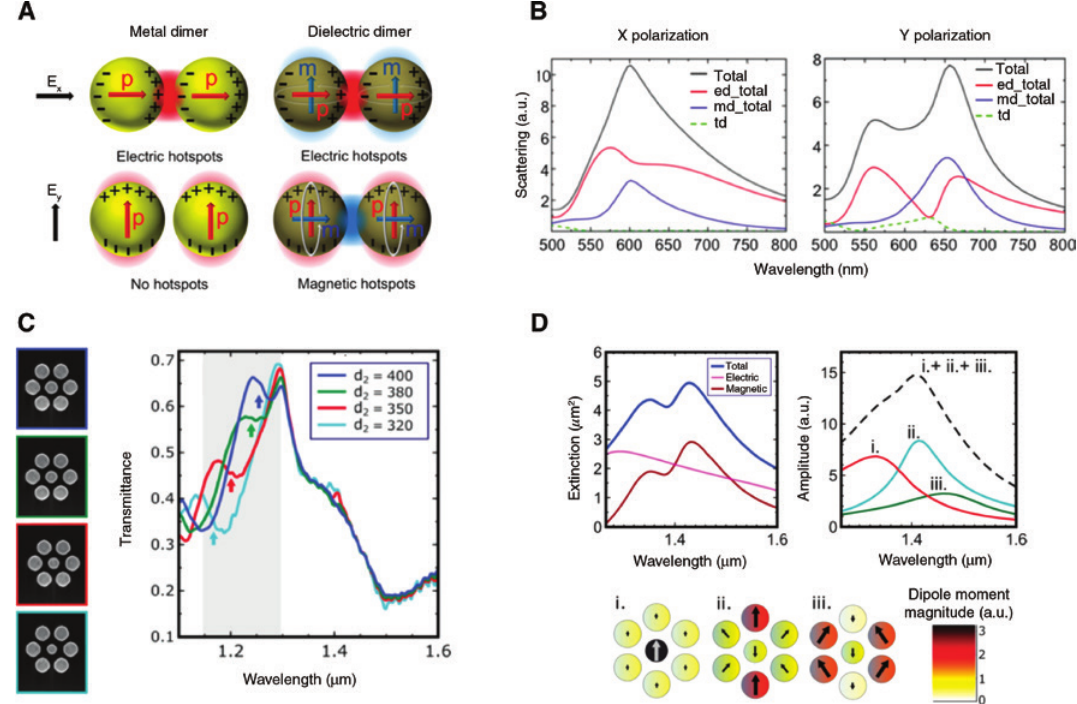
Figure 8: Recovering Fano-like magnetic modes through dielectric oligomers. (A) Comparison of metallic (plasmonic) and dielectric nanodimers: dielectric nanoparticles support both electric and magnetic dipoles that couple with both orthogonal polarizations of the incident light field. (B) Numerical results for a silicon dimer. X- (left) and Y-polarized (right) light scattering spectra with mode decomposition. Adapted with permission from Bakker RM, Permyakov D, Yu YF, et al. Magnetic and electric hotspots with silicon nanodimers. Nano Lett 2015;15:2137–42 (Ref. [57]). Copyright 2015 American Chemical Society. (C) Left, scanning electron micrographs of the fabricated heptamer oligomers featuring different diameters of the central nanoparticle. Right, measured extinction spectrum of the oligomers. A Fano resonance is created in the heptamers (see gray-shaded region and colored arrows), and it moves across the spectrum as the diameter of the central particle d is varied. (D) Top-left, simulated total extinction cross- 2 section spectrum of the silicon disk heptamers (blue curve) and the electric (purple curve) and magnetic (red) contribution. Top-right, decomposition of the heptamer magnetic response into three eigenmodes (denoted as i–iii). Bottom, the distribution of the magnetic dipoles in each eigenmode. The Fano signature appear at intersection of eigenmodes i and ii. Adapted with permission from Chong KE, Hopkins B, Staude I, et al. Observation of Fano resonances in all-dielectric nanoparticle oligomers. Small 2014;10:1985–90 (Ref. [60]). Copyright 2014 Wiley-VCH Verlag GMBH & Co. KGaA,